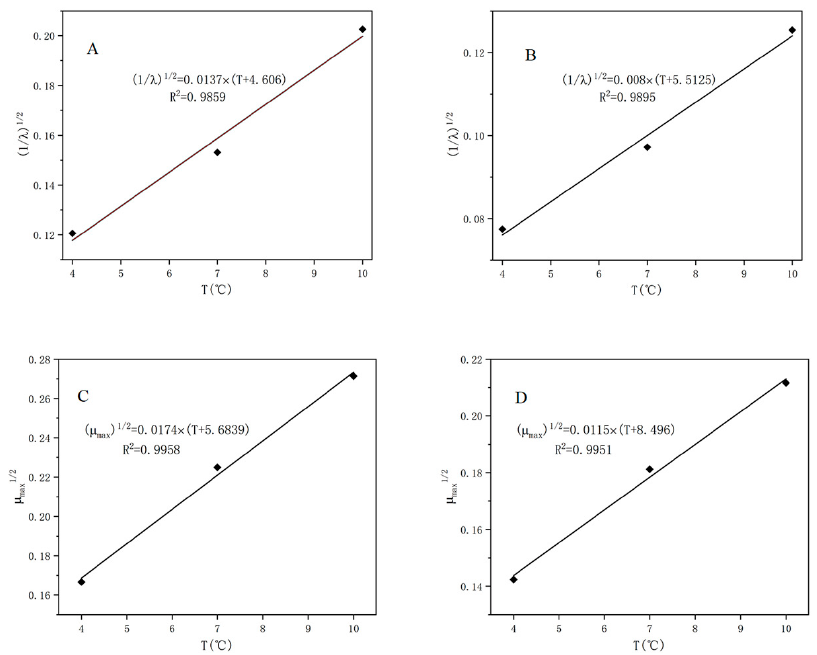
Figure 4. The secondary growth models of S. putrefaciens based on modified Gompertz ( A , C ) and logistic model ( B , D ).